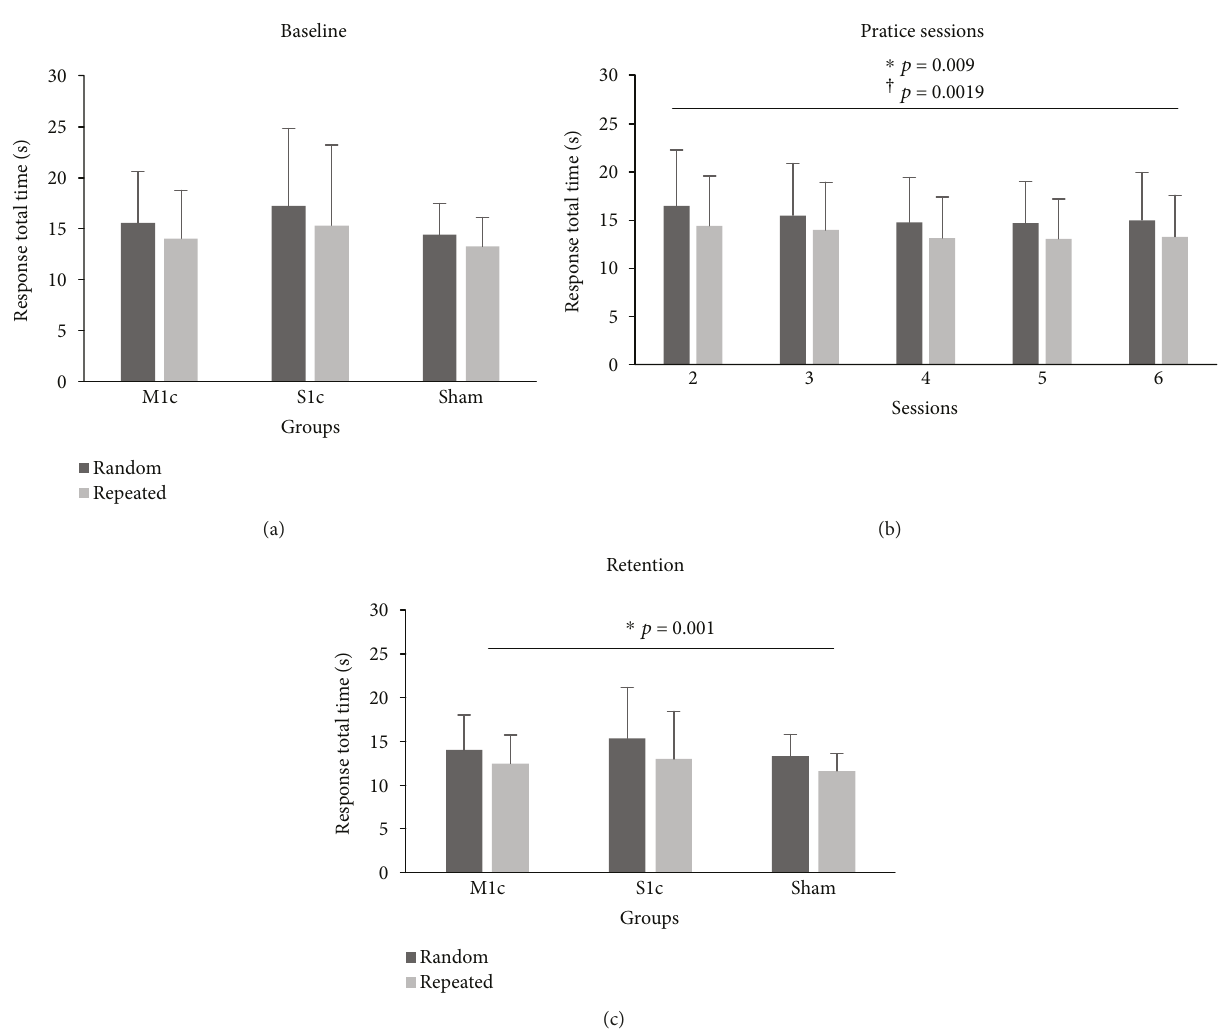
Figure 5: (a, b, and c) Mean response total time (RTT) for repeated and random sequences. Stimulation groups (M1c, S1c, and sham) demonstrated similar performances for repeated and random sequences on session 1 (baseline), 2 to 6, and 7 (retention). (a) All groups demonstrated initial faster RTTs for repeated compared to random sequence performance. (b) Collapsed across groups, all individuals demonstrated faster performance for repeated compared to random sequences across the fi ve days of practice: F (c) All groups demonstrated faster RTTs for repeated compared to random sequence during retention performance: F 0 001 . Error bars are SD of the